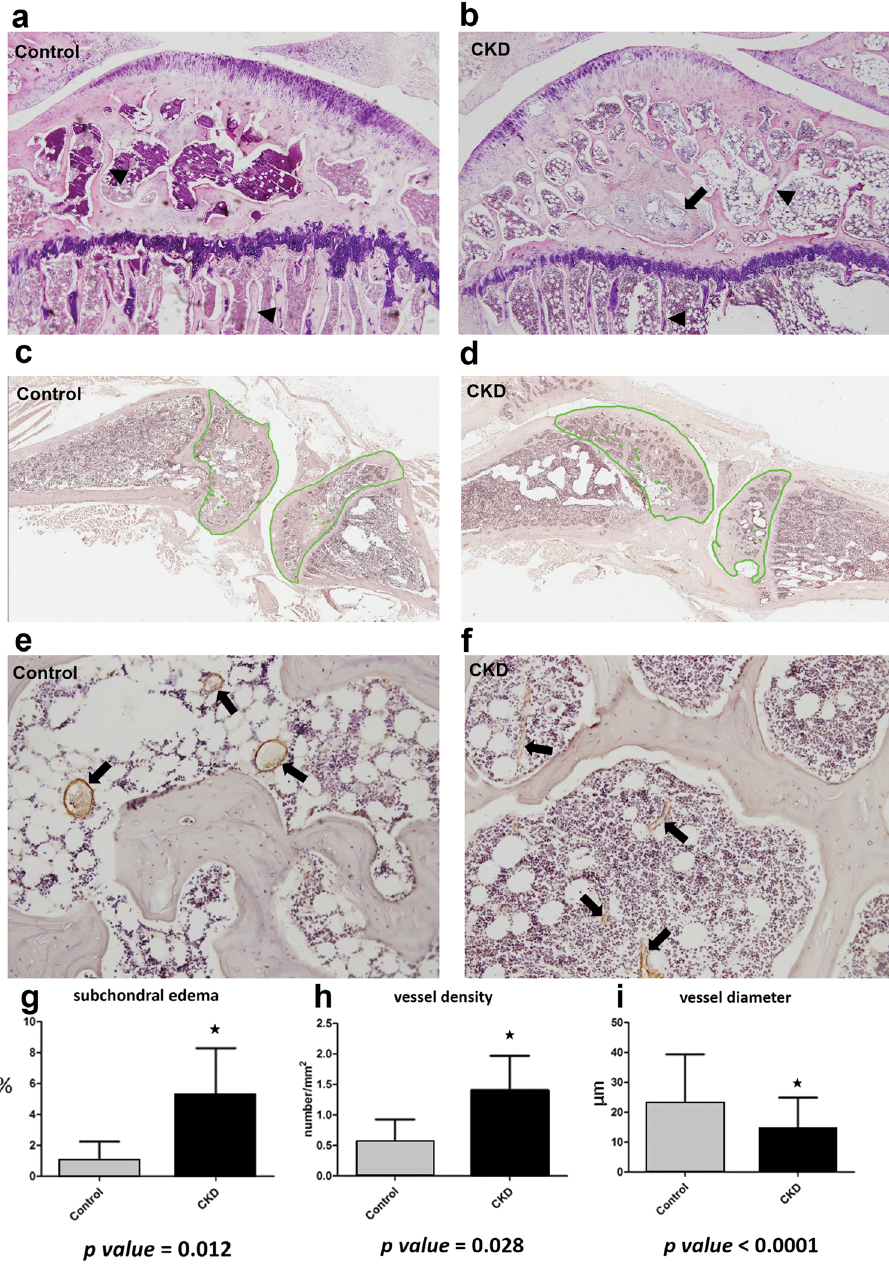
Figure 6. Histologic and immunohistochemical examination of the subchondral bone marrow in the control and CKD groups. Areas of subchondral bone marrow edema were statistically larger in the CKD group ( b : arrow, H&E x40 and g ) than in the control group ( a : H&E x40 and g ). Trabeculae were also thinner in the CKD group ( b , arrowheads) than control ( a , arrowheads). Images of subchondral marrow immunohistochemically stained with anti-alpha smooth muscle actin were analyzed using the dedicated software Image Scope (Aperio ® , Leica Microsystems, Nanterre, France). The average vessel density was statistically significantly higher in CKD rats ( d : green spots and h ) than in control rats ( c : green spots and h ) and the average vessel diameter was statistically significantly smaller in CKD rats ( f : arrows, x200 and i ) than in control rats ( e : arrows, x200 and i